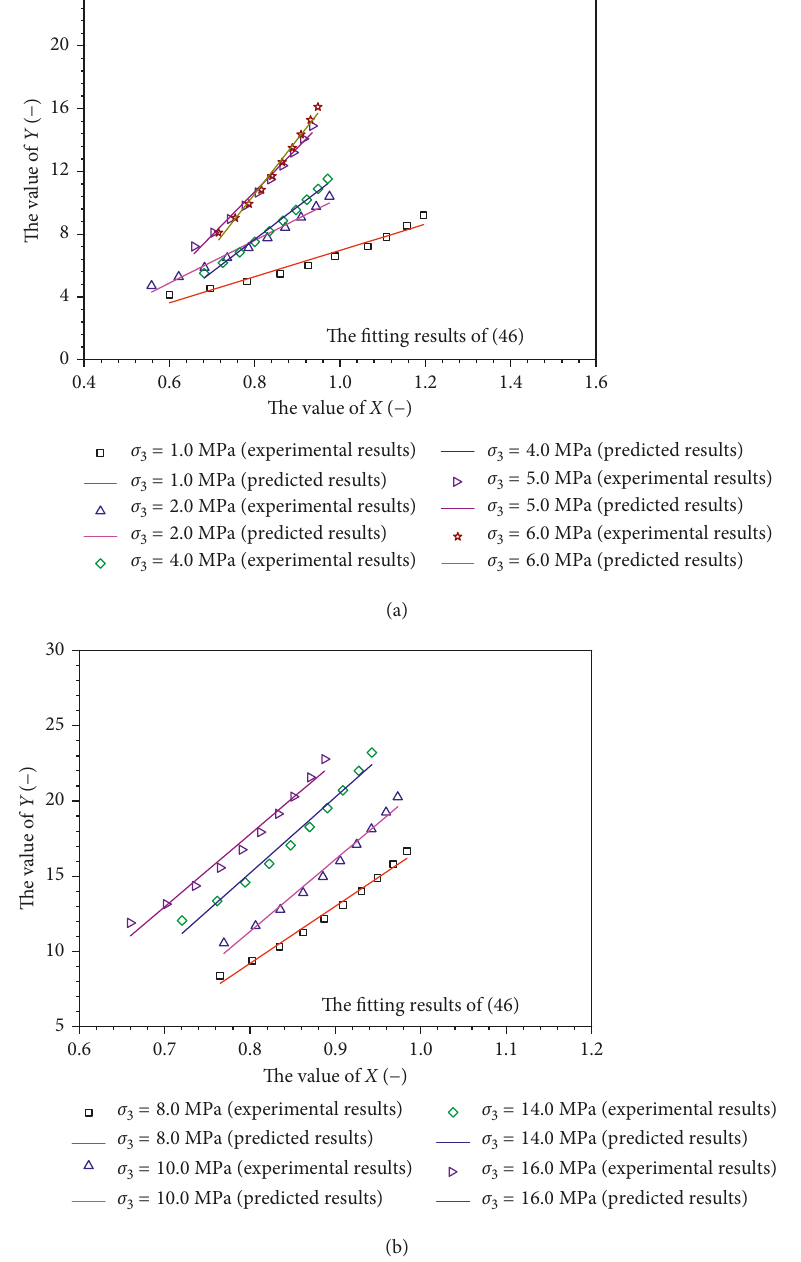
Figure 11: The relationship between the parameters Y and X of (46) under different confining pressures: (a) 1.0–6.0 MPa and (b)